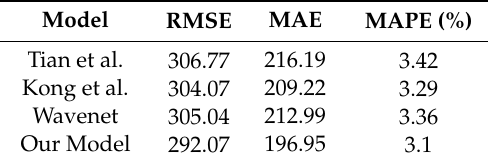
Table 3. Forecasting result obtained European Network of Transmission System Operators for Electricity (ENTSO-E) testing dataset 2.